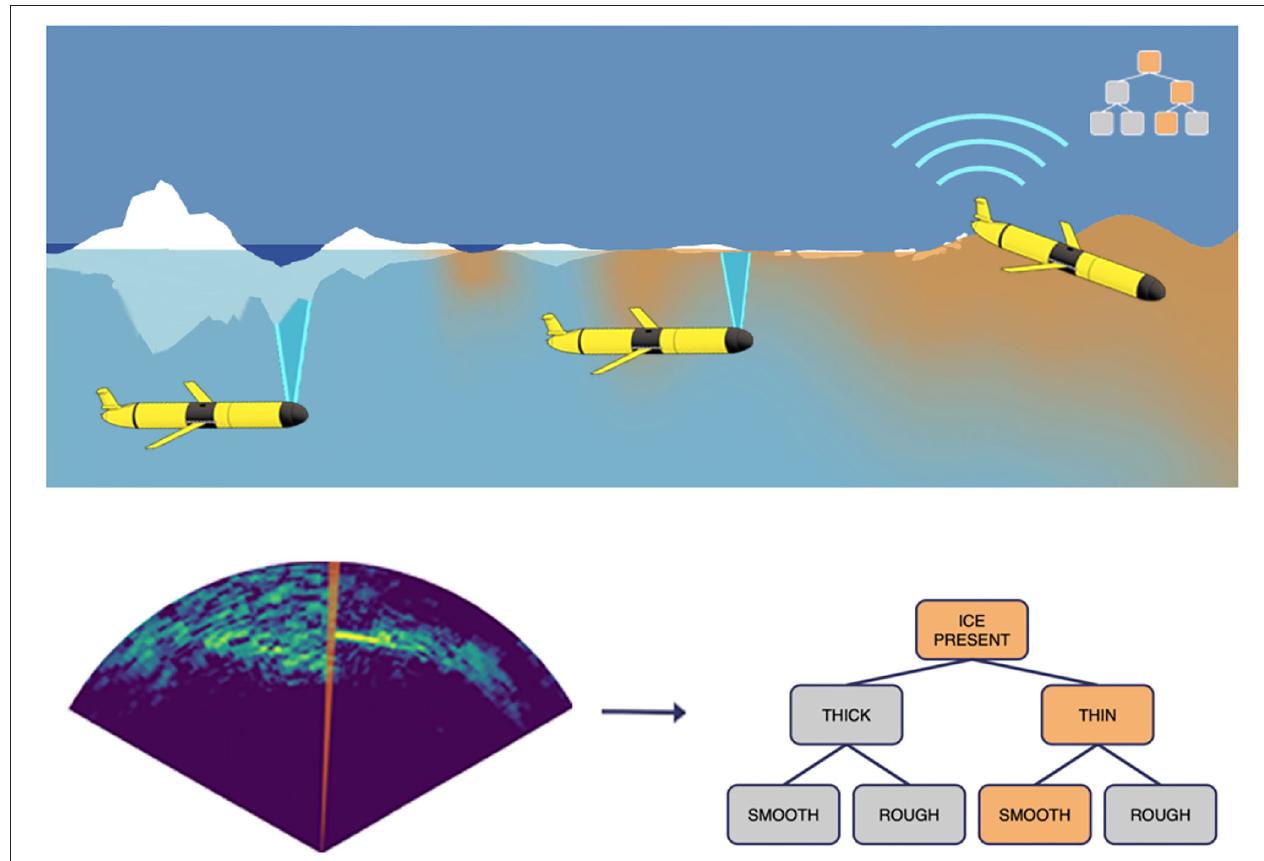
FIGURE 8 | Schematic diagram of glider sampling sea-ice in the Arctic and transmitting sea-ice information via satellite communication. The glider processes a sequence of acoustic scan-lines in the form of an acoustic image, and then the onboard sensor processing module compresses the raw data into a hierarchical sea-ice characterization structure based on three primary feature: sea-ice presence, sea-ice thickness, and sea-ice roughness. The compressed classification is then transmitted to shore-side via periodic satellite communication during vehicle surfacing, which requires significantly less time and energy than communicating the raw sea-ice data complement. Figure adapted from Lee et al.